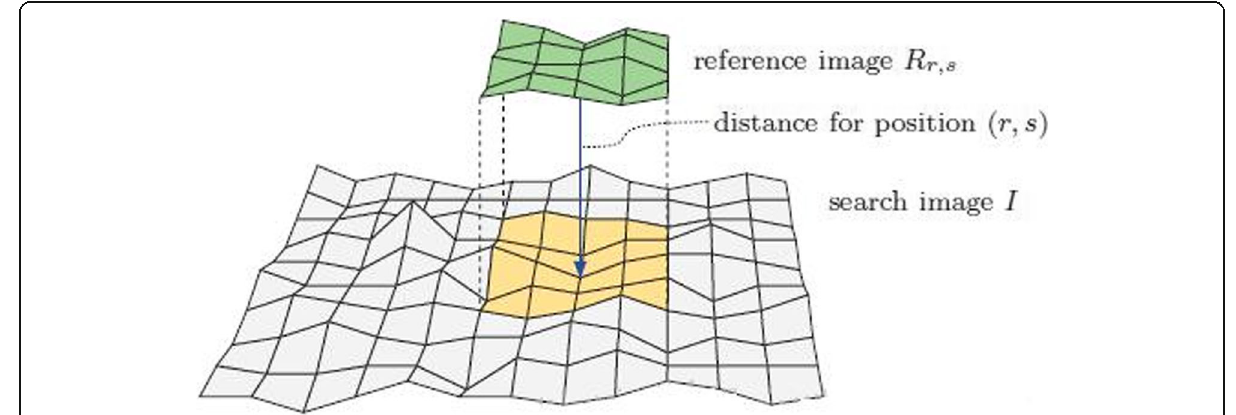
Fig. 6 Diagram of image measurement